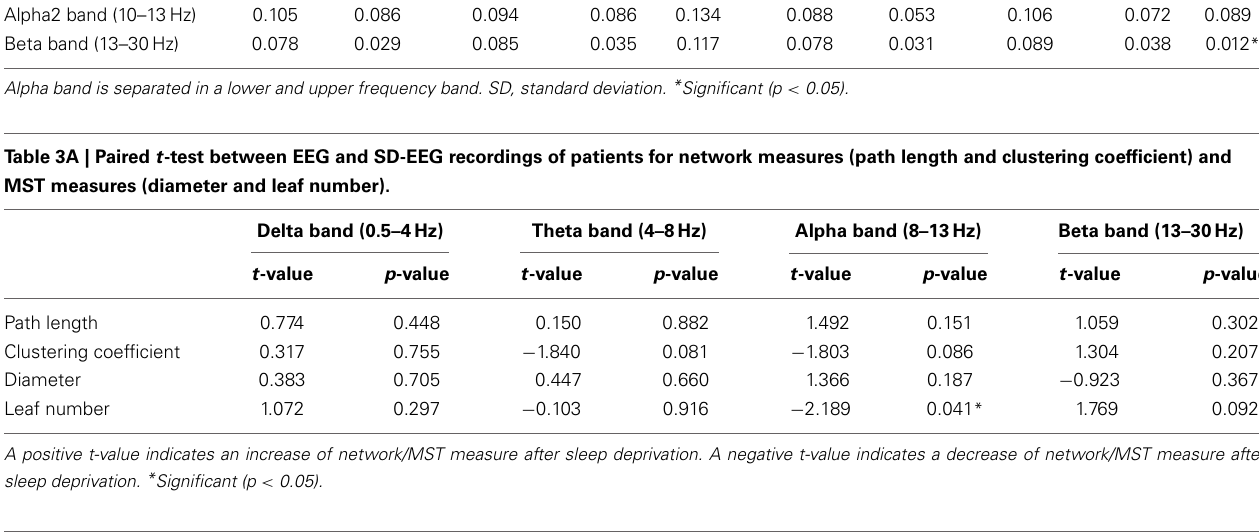
A positive t-value indicates an increase of network/MST measure after sleep deprivation. A negative t-value indicates a decrease of network/MST measure after sleep deprivation. * Significant (p < 0.05).